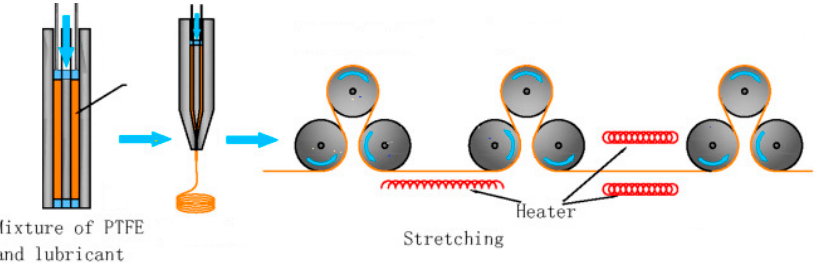
Figure 1. Stretching process.